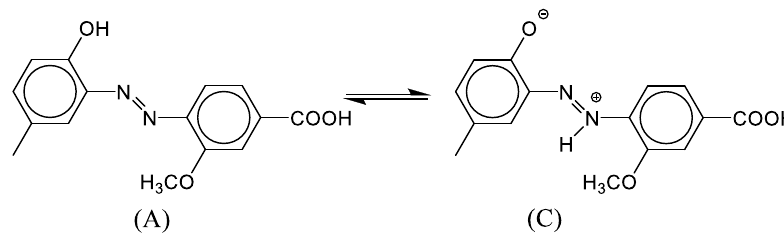
Table 6. AZO2 k r (in s − 1 ) constants in different solvents at different temperatures.